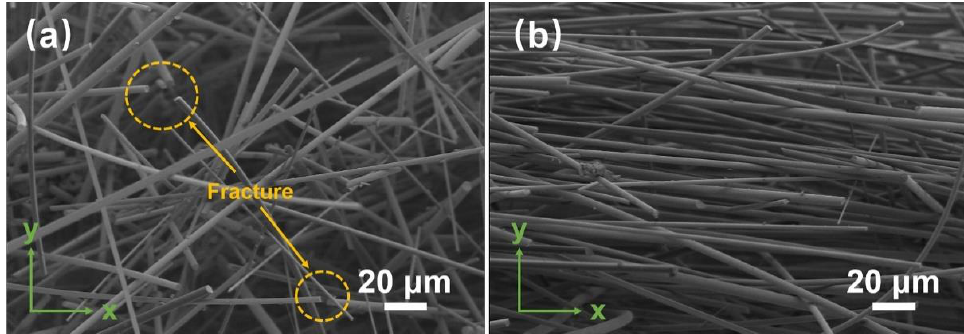
Figure 9. SEM images of SiO 2 fibrous porous ceramics with 0.4 wt% SHMP content under different applied strains. ( a ) 30% and ( b ) 50%. applied strains. ( a ) 30% and ( b )